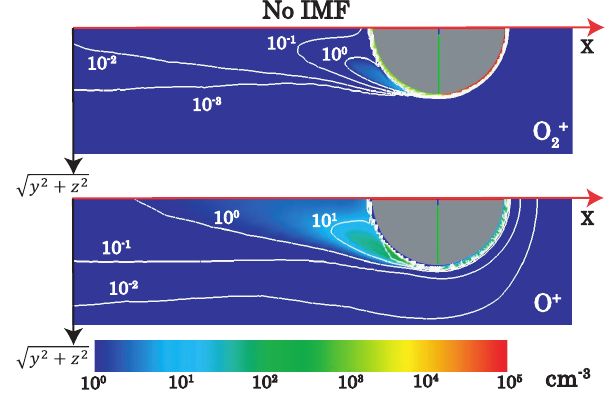
Fig. 5. The distribution of O + IMF. The vertical axis is